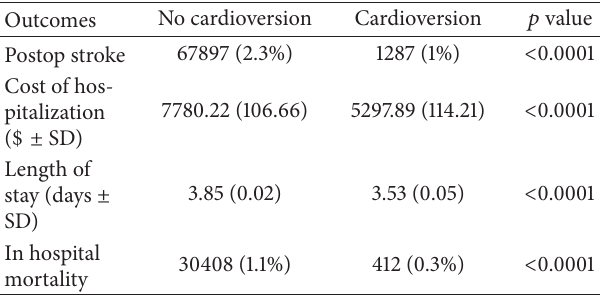
Table 2: Differences in clinical outcomes between patients hospital- ized for AF based on use of cardioversion.